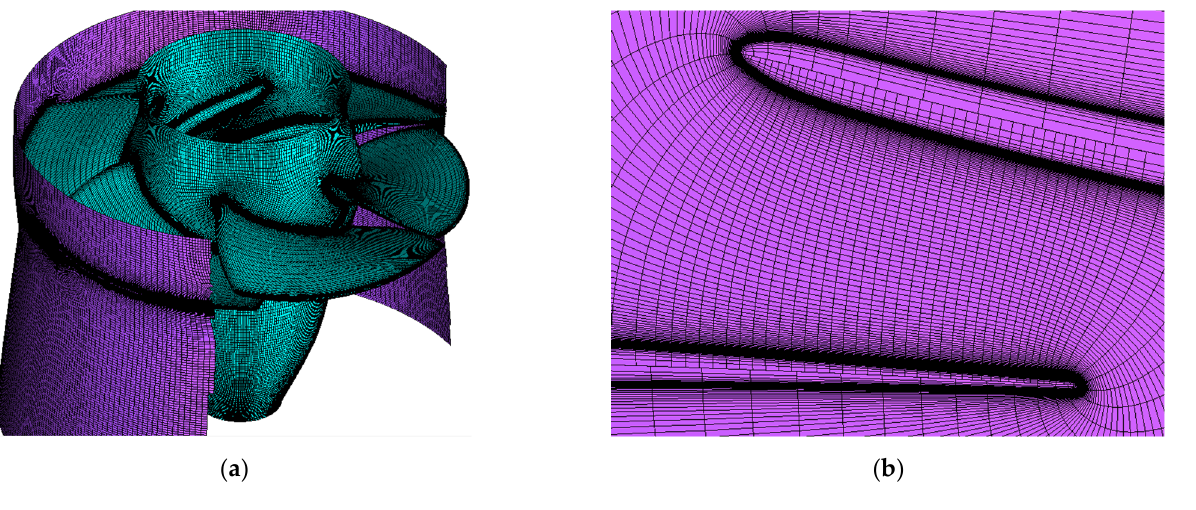
Figure 5. ( a ) Runner mesh. ( b ) Zoom on the inter-blade mesh.